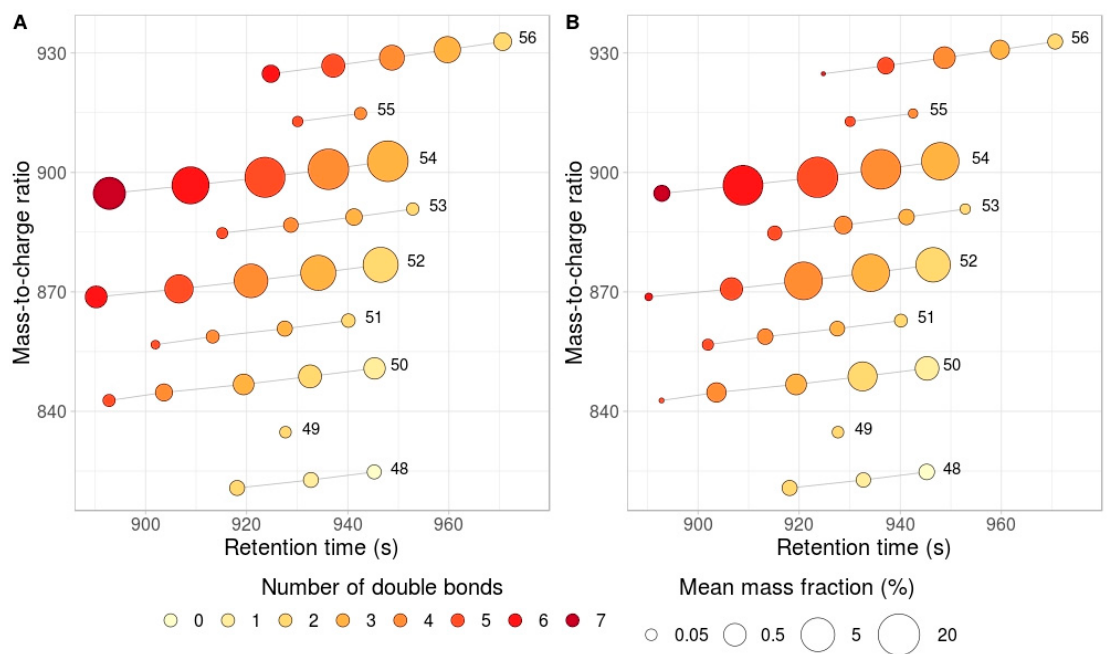
Figure 1. Retention time –mass to charge plot for ( A ) rapeseed and ( B ) sunflower. Single dot corresponds to a single triglyceride, retention time (seconds) and m / z are shown on x - and y -axis, respectively. Color scale represents the number of double bonds. Circle size represents the mass fraction. Grey lines connect TAGs with the same fatty acids carbon chain length (indicated at the right end of each line).